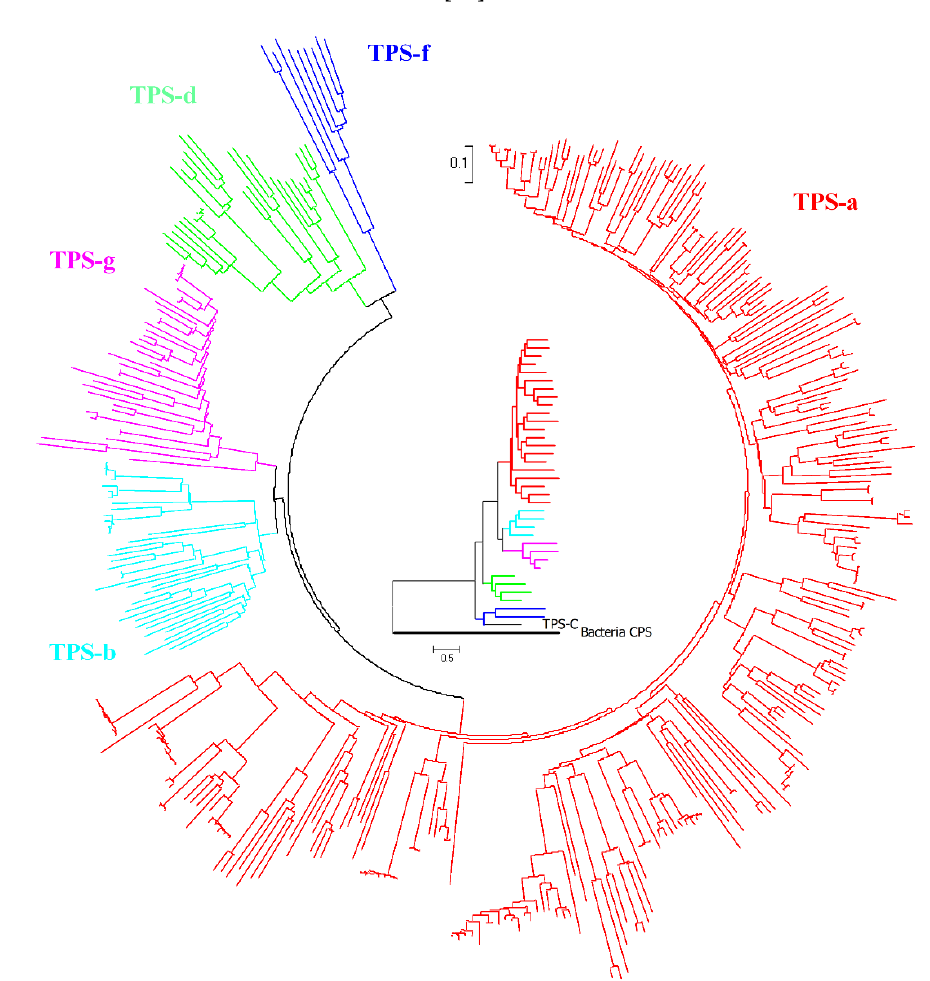
Figure 3. Phylogeny of functional spermatophyte STSs. Outer ring is the phylogenetic tree of all 394 spermatophyte STSs, inner ring is the global phylogenetic tree of representative plant STSs. Red branches represent TPS-a subfamily STSs, light blue branches represent TPS-b subfamily STSs, green branches represent TPS-d subfamily STSs, blue branches represent TPS-f subfamily STSs, pink branches represent TPS-g subfamily STSs.